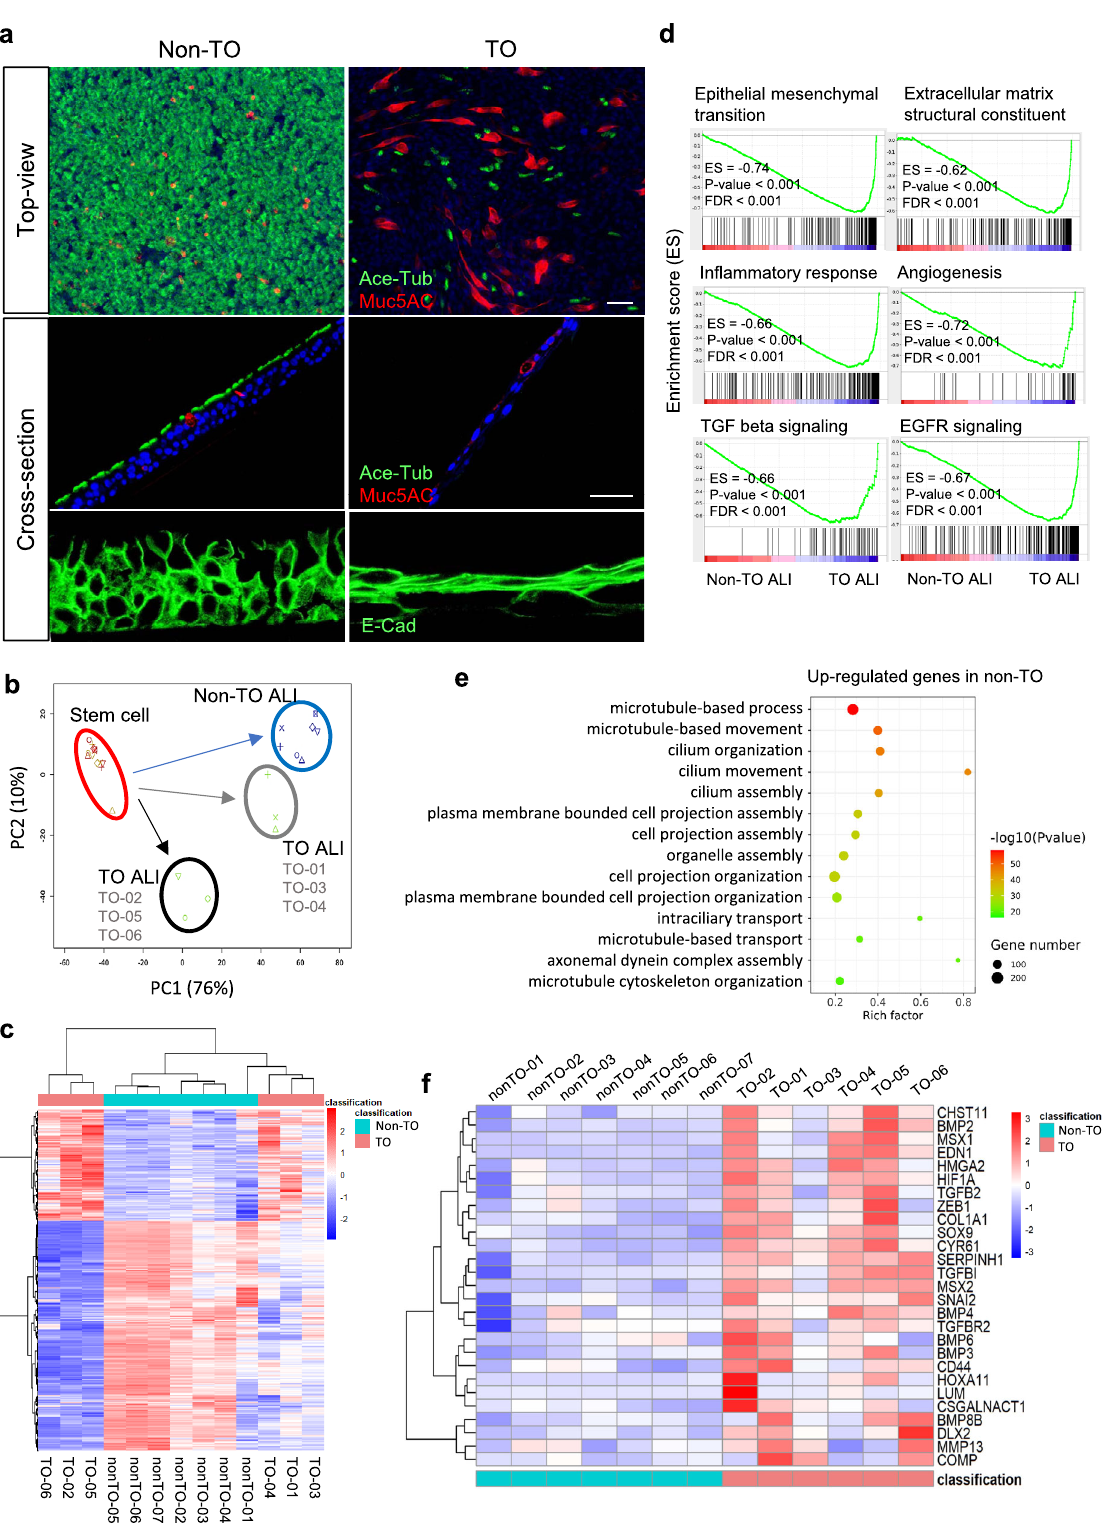
Fig. 2 Differentiation potential of TO derived basal cells and transcriptional pro fi les of ALI structures. a Basal cells underwent 20 days of differentiation on air – liquid interface (ALI) were stained with acetylated tubulin (Ace-Tub) and Muc5AC antibodies to reveal mucociliogenic ef fi ciency (non-TO n = 7, TO n = 6 independent biological samples). E-Cadherin staining on cross-sections showing architectures of ALI structures. Scale bar, 50 μ m. b Day20-ALIs were subjected to RNA-Seq. Whole-genome pro fi les of TBBCs before and after differentiation were displayed by PCA. c Differential expression between non-TO control-ALIs and TO-ALIs was visualized by heatmap with hierarchical clustering. d , e Gene Set Enrichment and GO enrichment analyses of RNA- Seq datasets derived from control and TO-ALIs. f Heatmap of genes involved in the axis of cartilage development that differentially expressed between control and TO